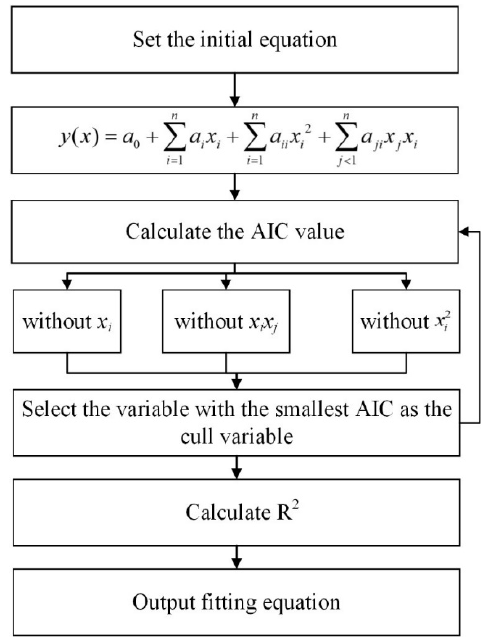
Figure 3. Stepwise regression calculation flow chart.